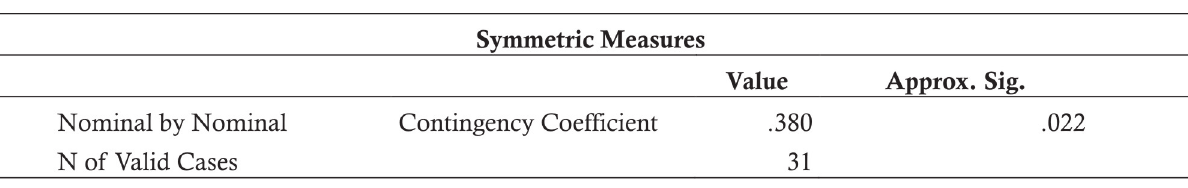
Table . Coefficient Contingency Correlation